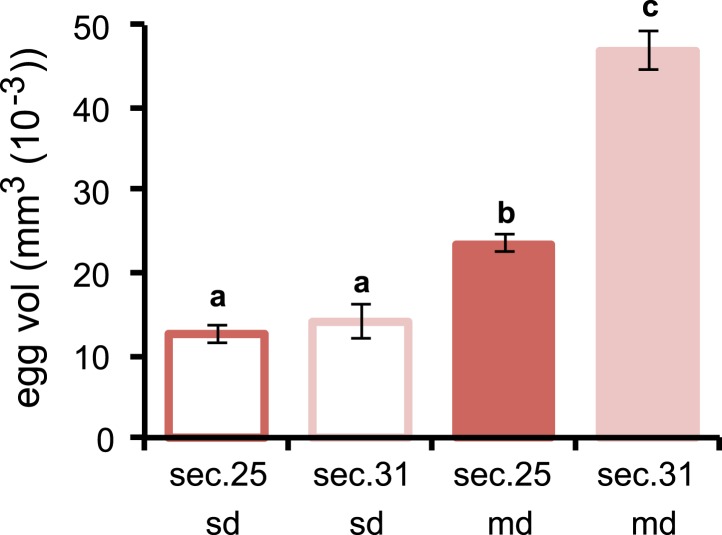
Volume of D. sechellia eggs is modulated by morinda diet.Volume (mm3 (10−3)) of D. sechellia 14021–0248.25 (sec.25) and D. sechellia 14021–0248.31 (sec.31) eggs produced by flies fed a standard diet (sd) or morinda diet (md) (N > 7). Different letters denote significant differences (p < 0.01) using ANOVA followed by Tukey's test. Error bars represent s.e.m.